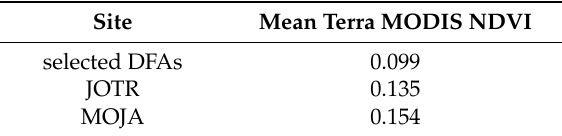
Table 6. Mean Terra MODIS NDVI by site (February 2000 through May